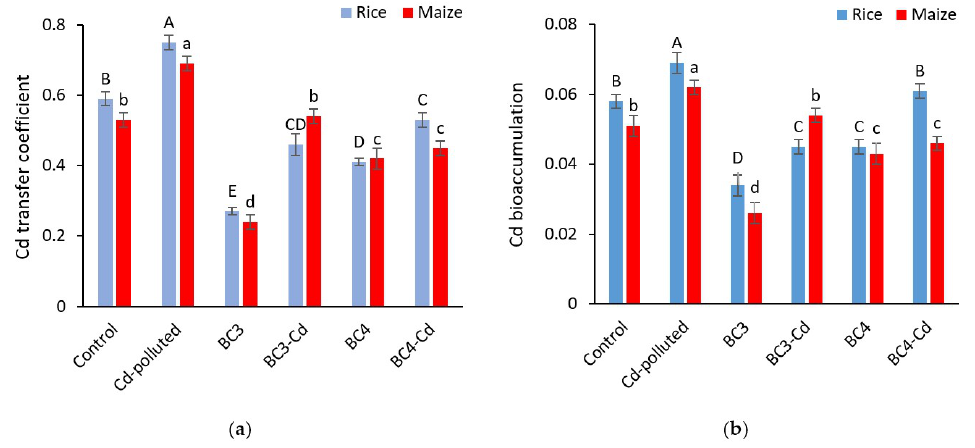
Figure 4. Effects of biochar and cadmium treatments on Cd bioaccumulation ( a ) and transfer coefficient ( b ) in rice and maize fields as representatives of C3 and C4 plants, respectively (means ± standard error). Significant differences of means are shown by different uppercase letters for rice and lowercase letters for maize ( p < 0.01). The values are means ± SD from three replicates (n = 3). BC3: rice biochar, BC4: maize biochar, BC3 + Cd: rice biochar + cadmium, and BC4 + Cd: maize biochar + cadmium.